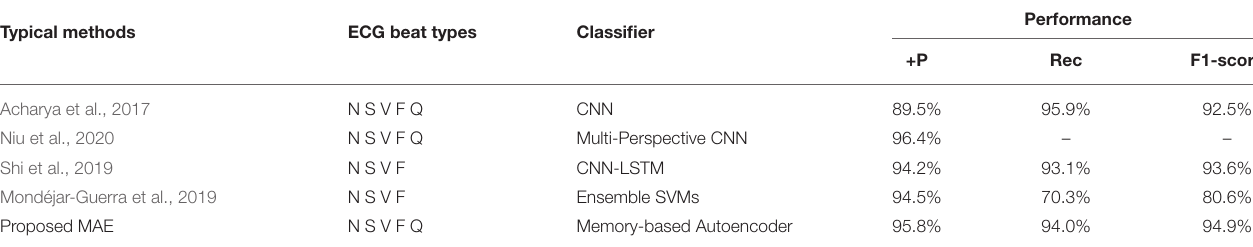
TABLE 6 | Comparisons with the popular methods for overall types on the MIT-BIH Arrhythmia